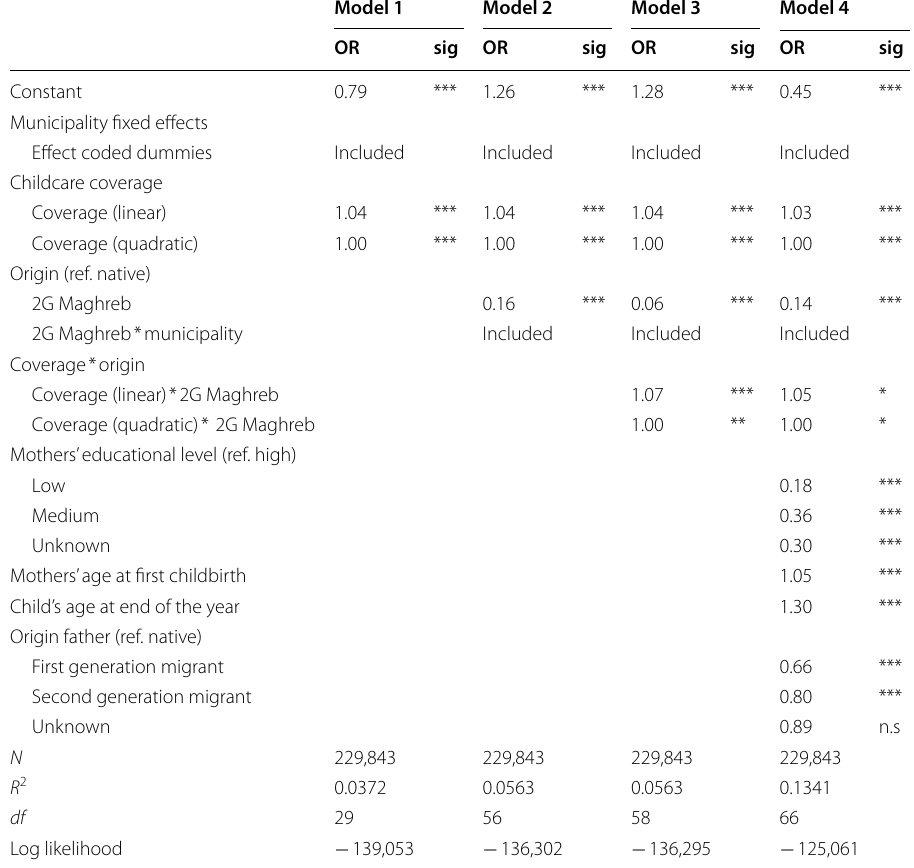
Table 3 Municipality-level fixed-effects logit models for the uptake of formal childcare, native and second generation Maghreb